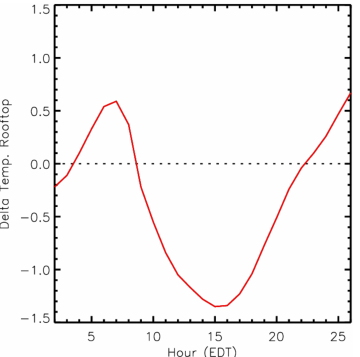
Figure 13. Air temperature difference above rooftops between the prognostic model level at 5-m − T diag and the diagnostic at the measurement level ( T prog ) averaged for 5 days (15, 19, and 23 July; 5 m 2.5 m 2 and 9 August 2015) and averaged for grid points with more than 30% of buildings (see Figure 5). Air water vapor content is traditionally evaluated in NWP with the dew point tem- perature, as it impacts numerous surface and boundary-layer processes. On Figure 14 is shown STDE and bias of T D at 2.5-m above ground level and 5-m above roof level. Near the ground (Figure 14a), STDE are lower in TOR-GEM250 than in HRDPS during the first 6 h of the simulations, slightly larger during the next 6 h, and lower again until the end of the simulation by 0.15 °C. This result indicates that the spatial variability is better represented in the new system. Bias is relatively small (Figure 14b) for the two systems between − 0.6 and 0.5 °C, but it is even smaller after 6 h of simulation in TOR-GEM250, almost nonexistent until the sunset after which the bias is improved by up to 0.4 °C in comparison to HRDPS. The bias has fewer diurnal variations as the fraction of impervious area in the surrounding of the station is better represented. The difference of representation of the buildings and roads between the two systems is obvious over the rooftop stations (Figure 14c,d). STDE errors remain improved during all the simulation and up to 0.3 °C during the afternoon, which is statistically significant. Due to the overestimation of the evapotranspiration of the soil and vegetation in HRDPS the bias for rooftop station is large and reaches 1.4 °C in the morning. In TOR-GEM250 the bias is improved by 1.3 °C during daytime and still by 0.4 °C during the second night. The diurnal cycle is less present in TOR-GEM250 as the fraction of vegetation is likely to be better